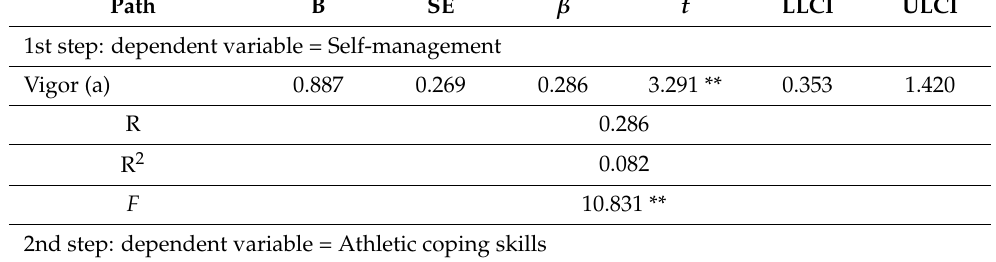
Table 7. The moderated mediation of vigor on sports coping skills through self-management.